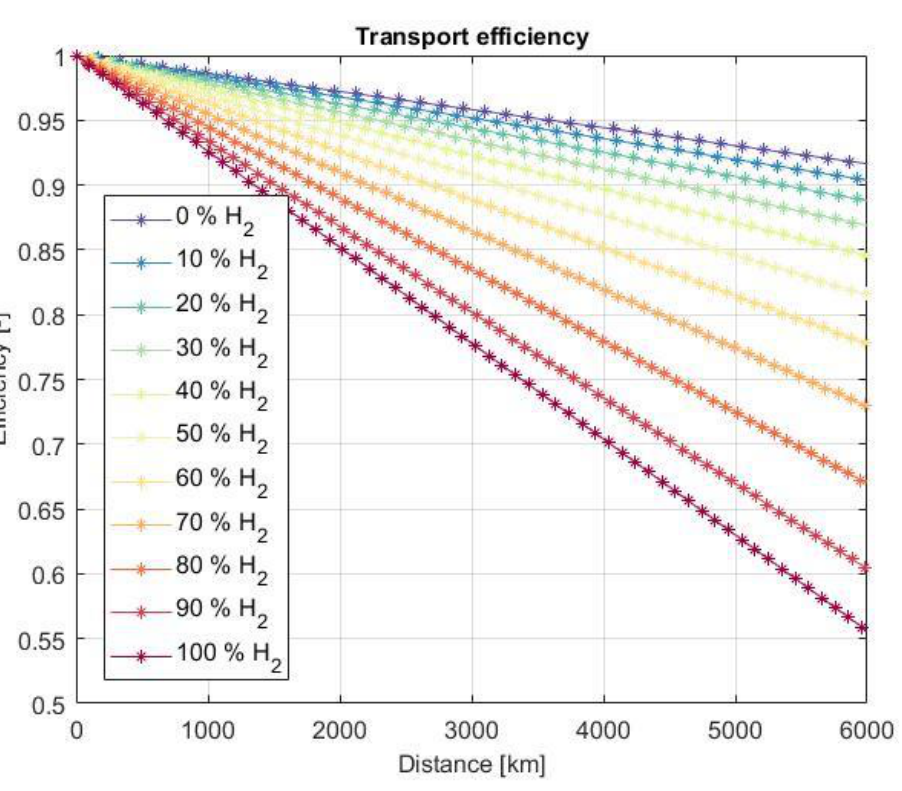
Figure 8. Transport efficiency of pipelines as function of H2 fraction and distance.